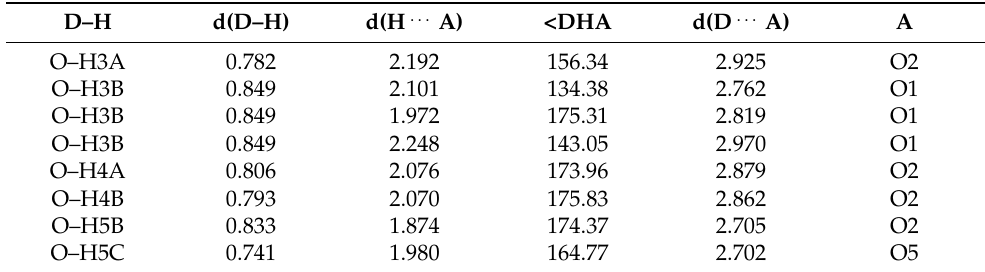
Table 7. Hydrogen bonding geometry (Å, ◦ ) for synthetic